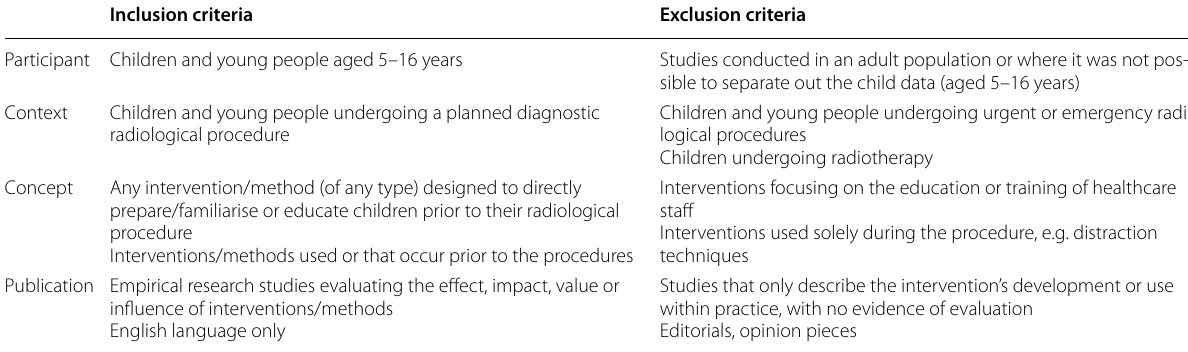
Table 1 Inclusion and Exclusion criteria Inclusion